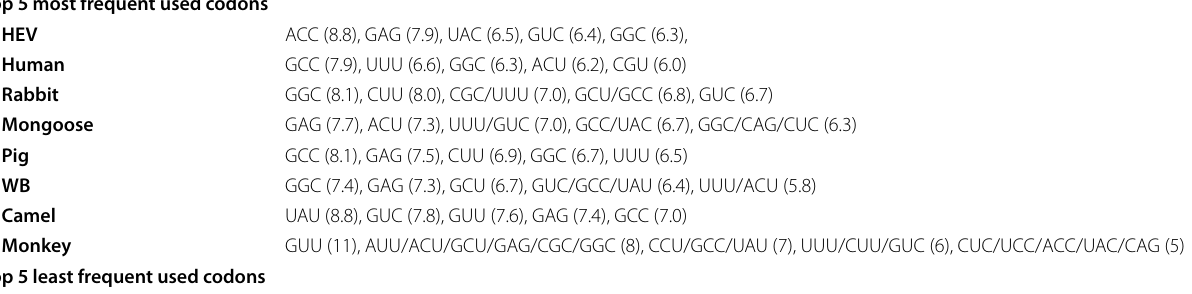
Table 4 Most frequent and least used codons among HEV and its natural hosts Top 5 most frequent used